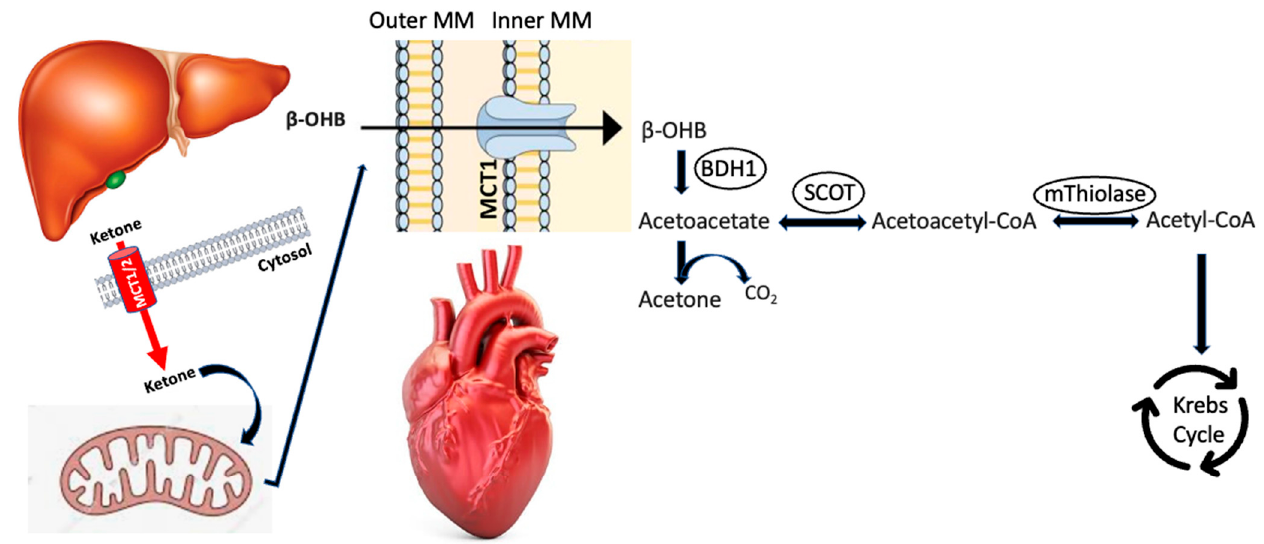
Figure 1. The schema illustrates ketone body production and oxidation. Ketone bodies produced in the liver are released via the monocarboxylate transporter (MCT) 1/2 into the circulation and reach extrahepatic tissues, including the heart, where they can be utilized as energy sources. Ketone body oxidation in cardiac tissue involves beta-hydroxybutyrate dehydrogenase 1 (BDH1), bound to the inner mitochondrial membrane (MM), which converts beta-hydroxybutyrate ( β -OHB) to acetoacetate. Acetoacetate can then be activated via succinyl-CoA:3-oxoacid-CoA transferase (SCOT) whereby a succinyl CoA is transferred to acetoacetate in order to form acetoacetyl CoA. Acetoacetyl CoA is subsequently cleaved to yield two acetyl CoA molecules which can then be oxidized in the tricarboxylic acid (Krebs) cycle. BDH1 = beta-hydroxybutyrate dehydrogenase; β -OHB = beta-hydroxybutyrate; CoA = coenzyme A; CO 2 = carbon dioxide; MCT = monocarboxylate transporter; MM = mitochondrial membrane; mThiolase = mitochondrial thiolase; NADH = nicotinamide ade- nine dinucleotide reduced; SCOT = succinyl-CoA:3-oxoacid-CoA trans-ferase.